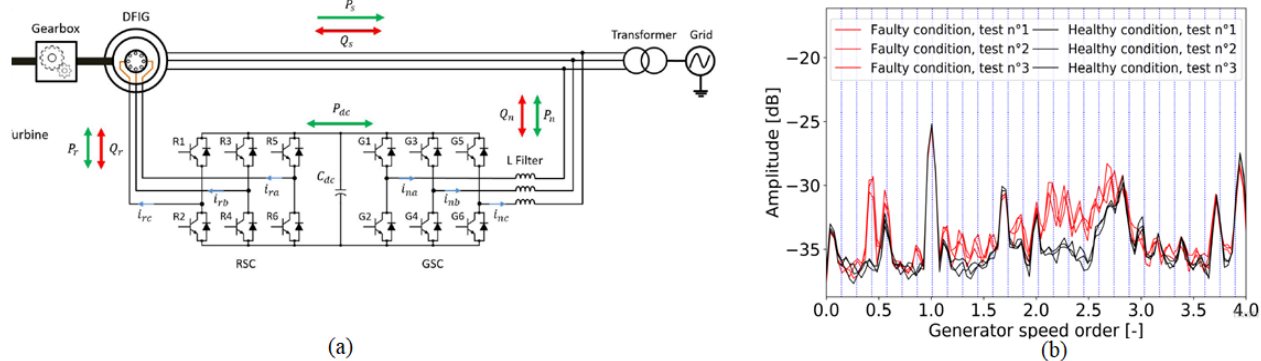
Figure 15. ( a ) DFIG wind turbine topology. ( b ) Comparison of the auto-power spectrum for healthy and faulty bearing faults in wind turbines for doubly fed induction generators. Reproduced with permission of [46].